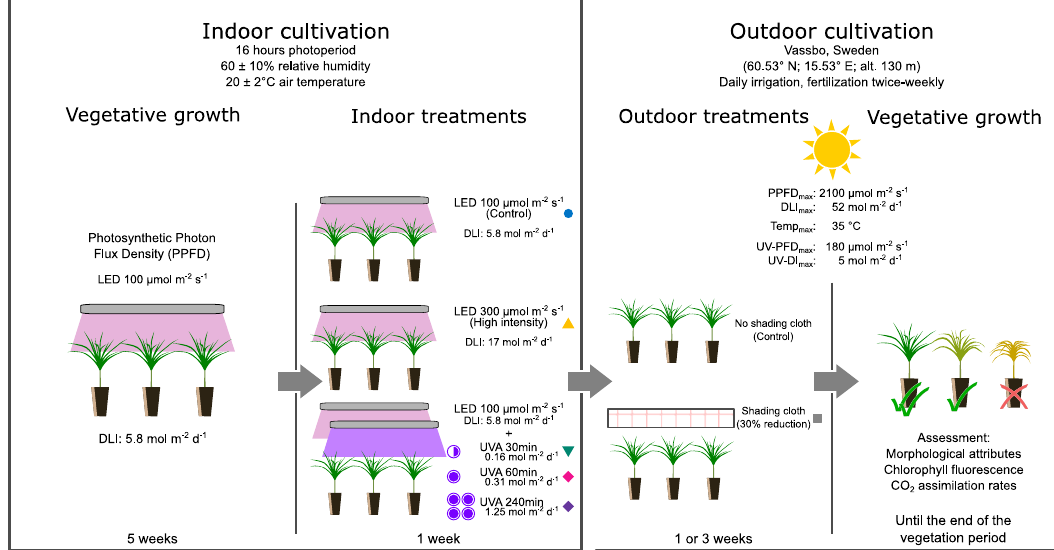
Figure 3. Summary of indoor and outdoor treatments applied in this study. Indoor cultivation was done in a growth room facility under artificial lights and completely deprived from solar